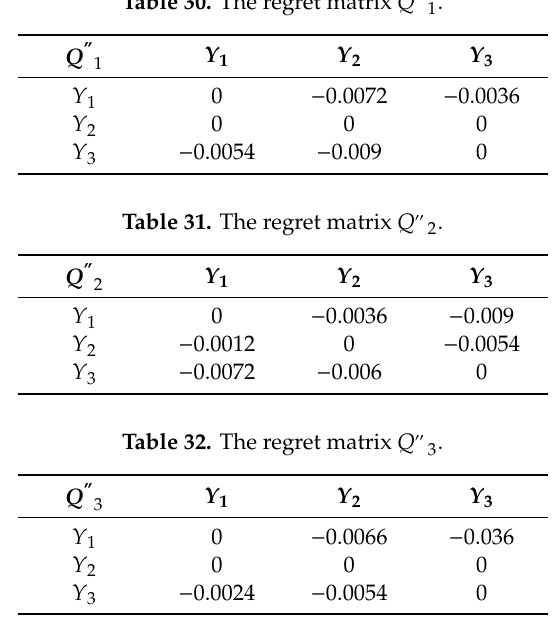
Table 33. The regret matrix Γ (cid:48)(cid:48) 1 .